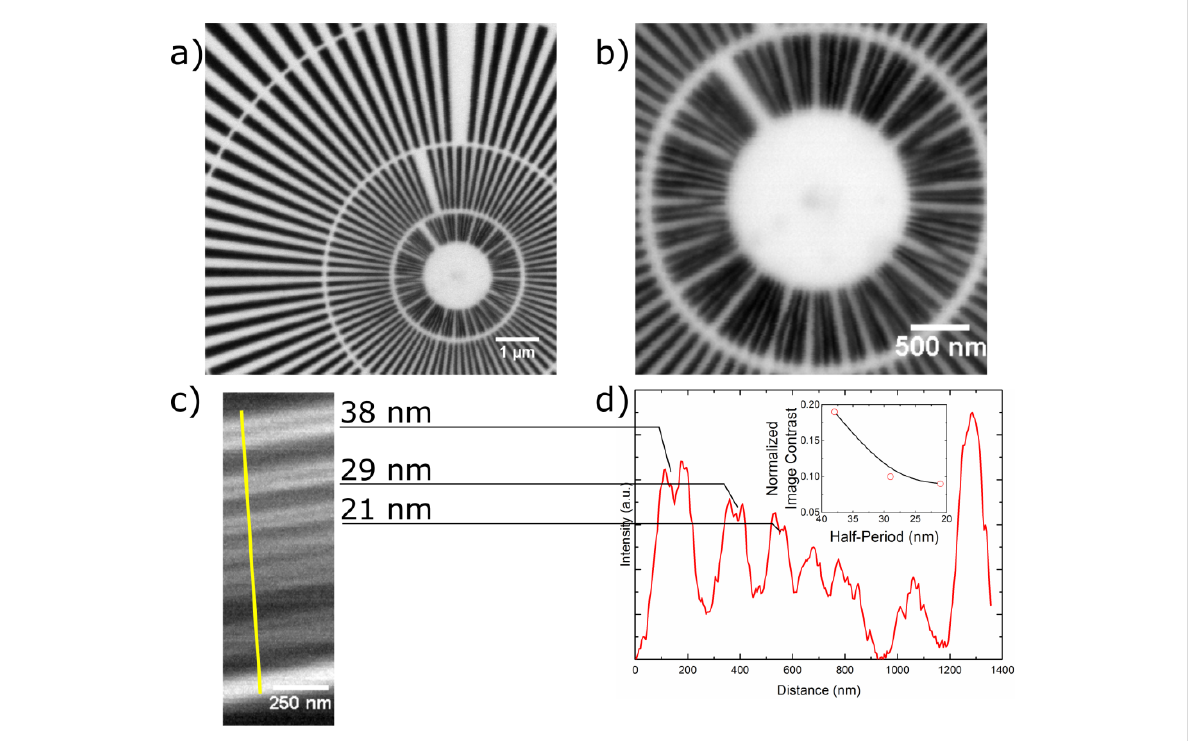
Figure 3: a) Soft X-ray image of the Siemens star recorded at 1 keV with 0.94 ms pixel dwell time and 11 nm step size. b) A higher-magnification image of the central ring recorded using 10 nm steps size and 10 nm dwell time. It can be seen that the smallest 30 nm features of the Siemens star are clearly resolved. c) An STXM image of the multilayer test object recorded at 1.12 keV with 30 ms dwell time and 5 nm step size. The 21 nm half- pitch features are resolved and the intensity profile in d), where the inset shows the normalized contrast of the first three features in the profile.